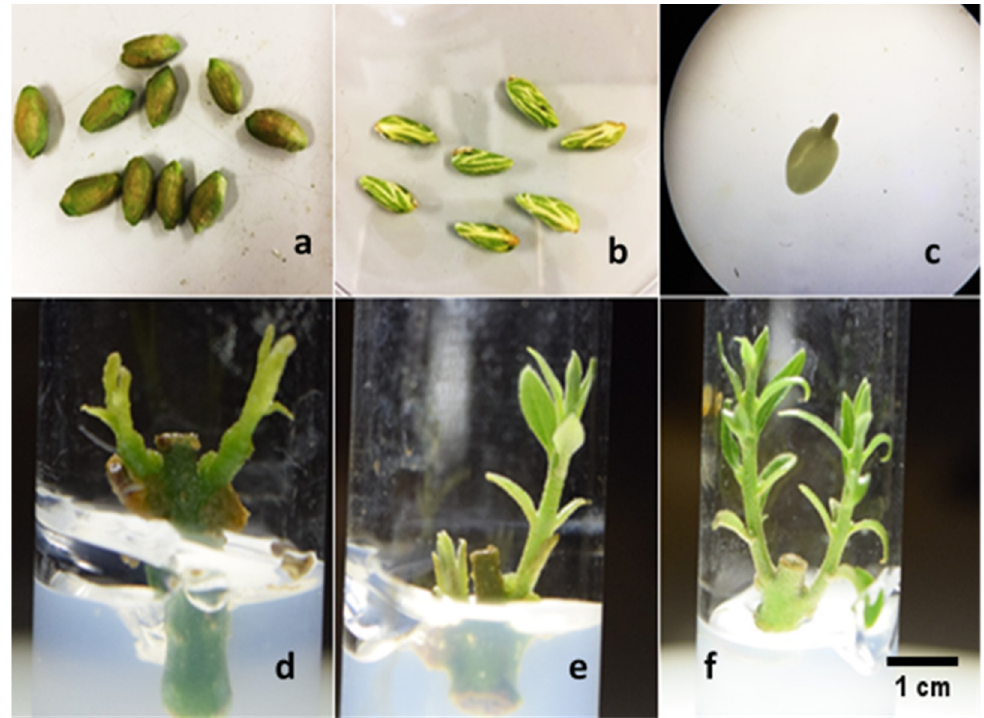
Figure 1. Lignified endocarp containing immature seeds ( a ), seeds released from the sclerified endocarp ( b ), naked embryos after endocarp, and seed coat and endosperm removed ( c ). Nodal explant producing hyperhydrated shoots, usually unable to convert into normal ones ( d ), normal shoots originated from the buds of the nodal explants of the cultivars F7P3 ( e ), and CS-3T ( f ). (Scale bar = 1 cm). Table 1. The contamination rates of the different explant sources (immature embryos of cv. Leccino and uni-nodal explants of the cultivars CS-3T and F7P3) and the bud development from the aseptic nodal explants of both cultivars. Data have been shown as the mean ± standard deviation. The mean denoted by different letters are significantly different (Duncan’s test, p < 0.05).